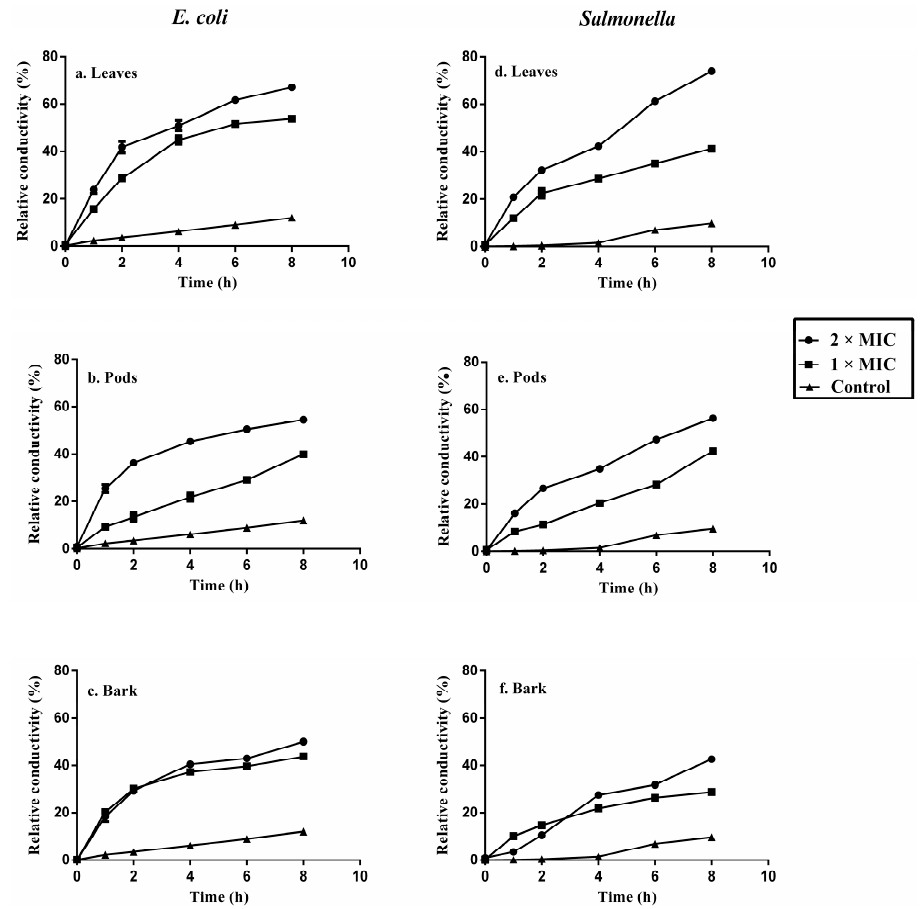
Figure 3. Effects of acacia leaves, pods and bark extracts on the impermeability of cell membrane of tested E. coli ( a – c ) and Salmonella typhimurium ( d – f )